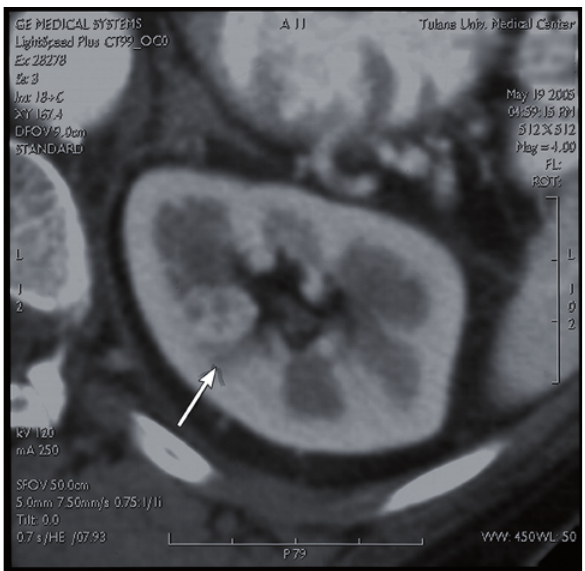
Figure 1 - Massive gas in the bladder, dissecting in the submucosal layer and extending into the space of